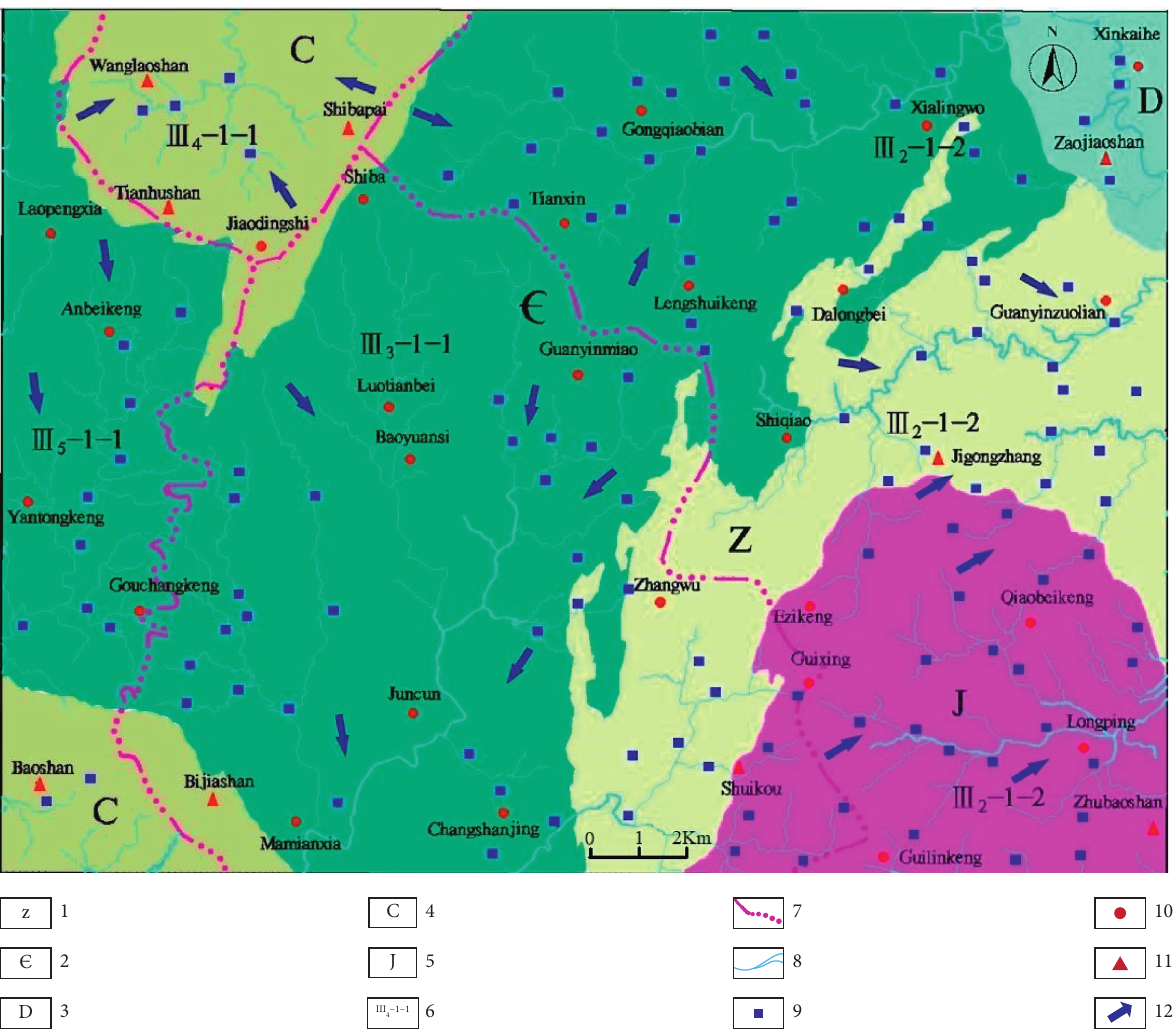
Figure 2: Sampling locations of groundwater in Northwest Xingguo County. 1: Sinian fissured water-bearing formation of metamorphic rock; 2: Cambrian fissured water-bearing formation of metamorphic rock; 3: Devonian porous-fissured water-bearing formation of clastic rock; 4: carboniferous porous-fissured water-bearing formation of clastic rock; 5: Jurassic fissured water-bearing formation of granite; 6: code of groundwater system; 7: boundary of fifth-scale groundwater subsystem; 8: surface water system; 9: sampling location; 10: village; 11: peak; and 12: groundwater flow